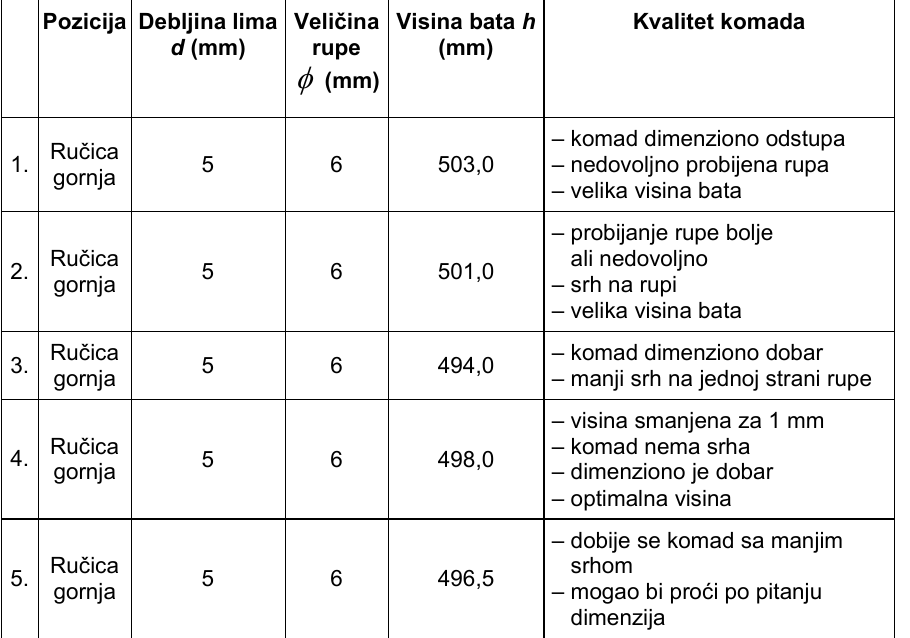
iz tabele 3 jeste da nema baš velike tolerancije na visini bata. Tabela 3 – Eksperimentalno podešavanje visine bata za poziciju „ru č ica gornja“ Table 3 – Experimental adjusting of the ram height for the “Ru č ica gornja” position Pozicija Debljina lima Veli č ina Visina bata h Kvalitet d (mm) rupe (mm) φ (mm)